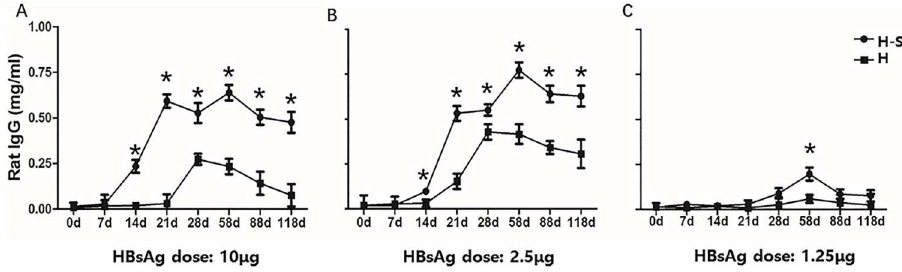
Fig 2. HBsAg specific antibody induced by SBP adjuvanted and non-adjuvanted vaccines. Rats (n = 10/group)were immunizedintramuscularly 3 times at a 2-week interval with vaccine alone (H) or together with SBP (H-S). There are 6 groups with 3 injected HBsAg dose: 1.25 μ g,2.5 μ gand 10 μ g. Blood samples were collectedon indicatedtime points and anti-HBs total IgG was measuredby ELISA. Results are expressedas the means ± SEM, * p <